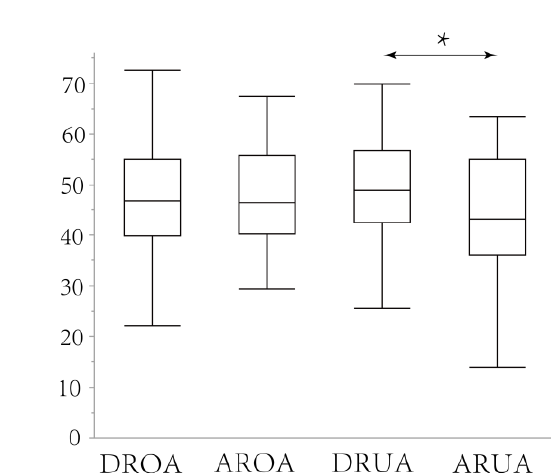
Figure 2. Processing of questionnaire date.